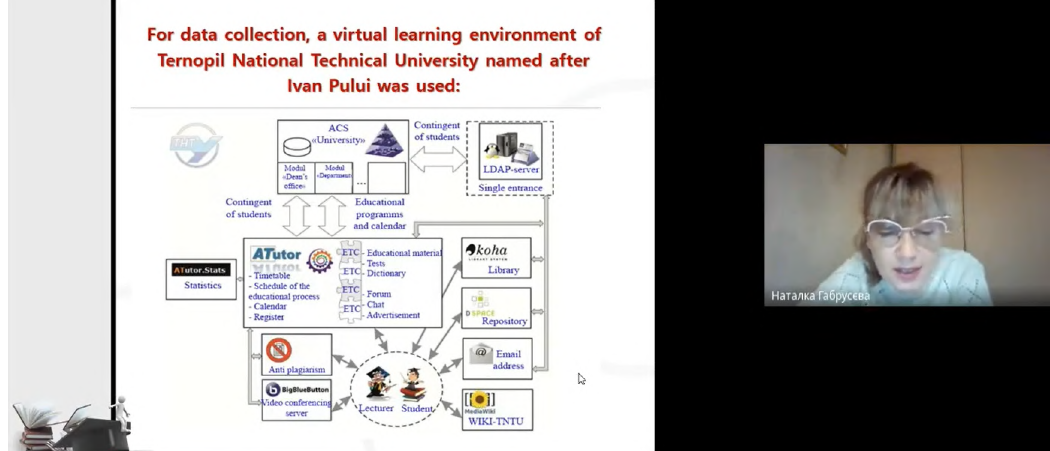
Figure 86: Presentation of paper